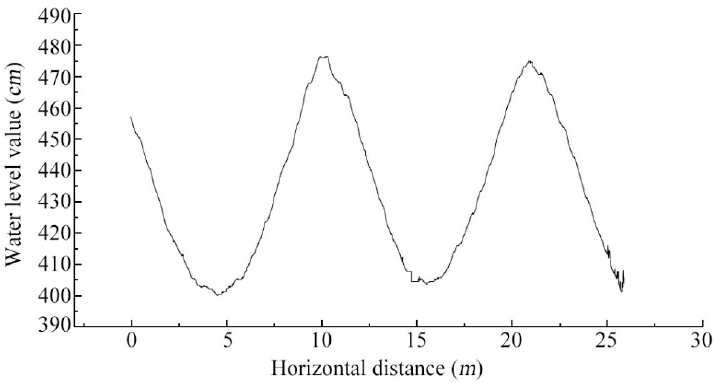
Figure 8. Filtered spatial wave figure.